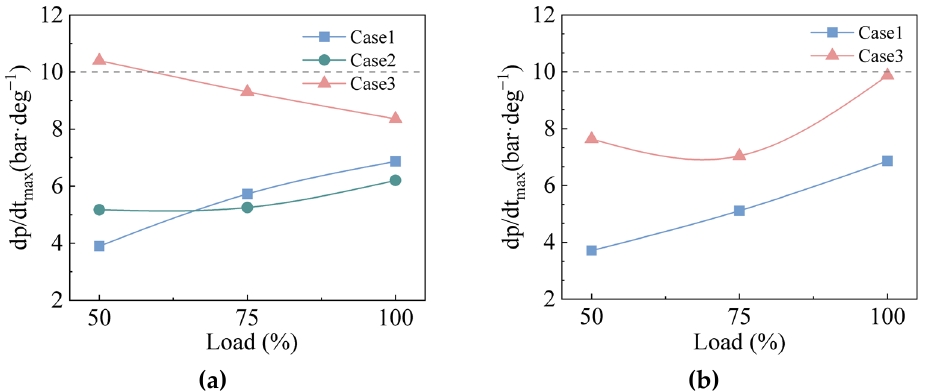
Figure 10. The trend of maximum pressure rise rate for variable EBP at different loads. ( a ) EBP = 10 kPa; ( b ) EBP = 25 kPa. ( b ) EBP = 25